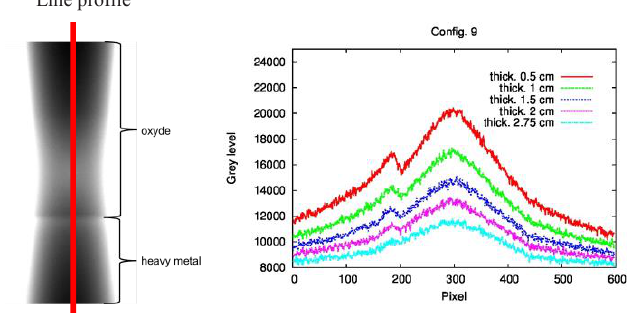
Fig. 11. On the left, simulated radiography of the corium bed with an oxide/heavy metal interface (configuration 9). On the right, comparison of vertical profiles of corium cylinder for different tickness of the autocrucible. The small peak corresponds to the interface visible on simulated